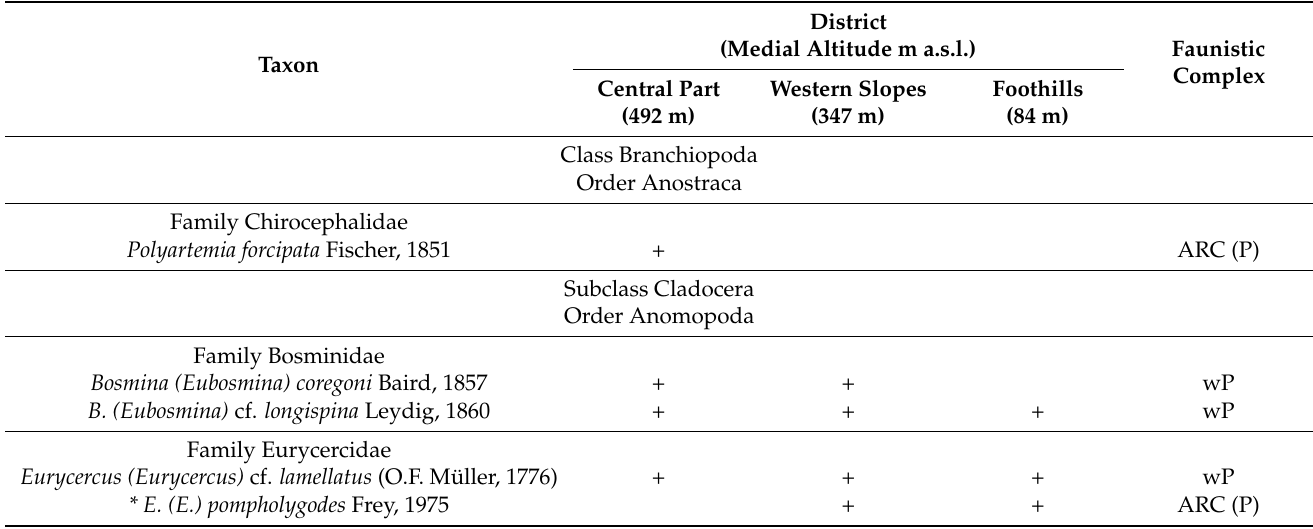
Table A1. Species list, presence and faunistic complexes of crustaceans from plankton and